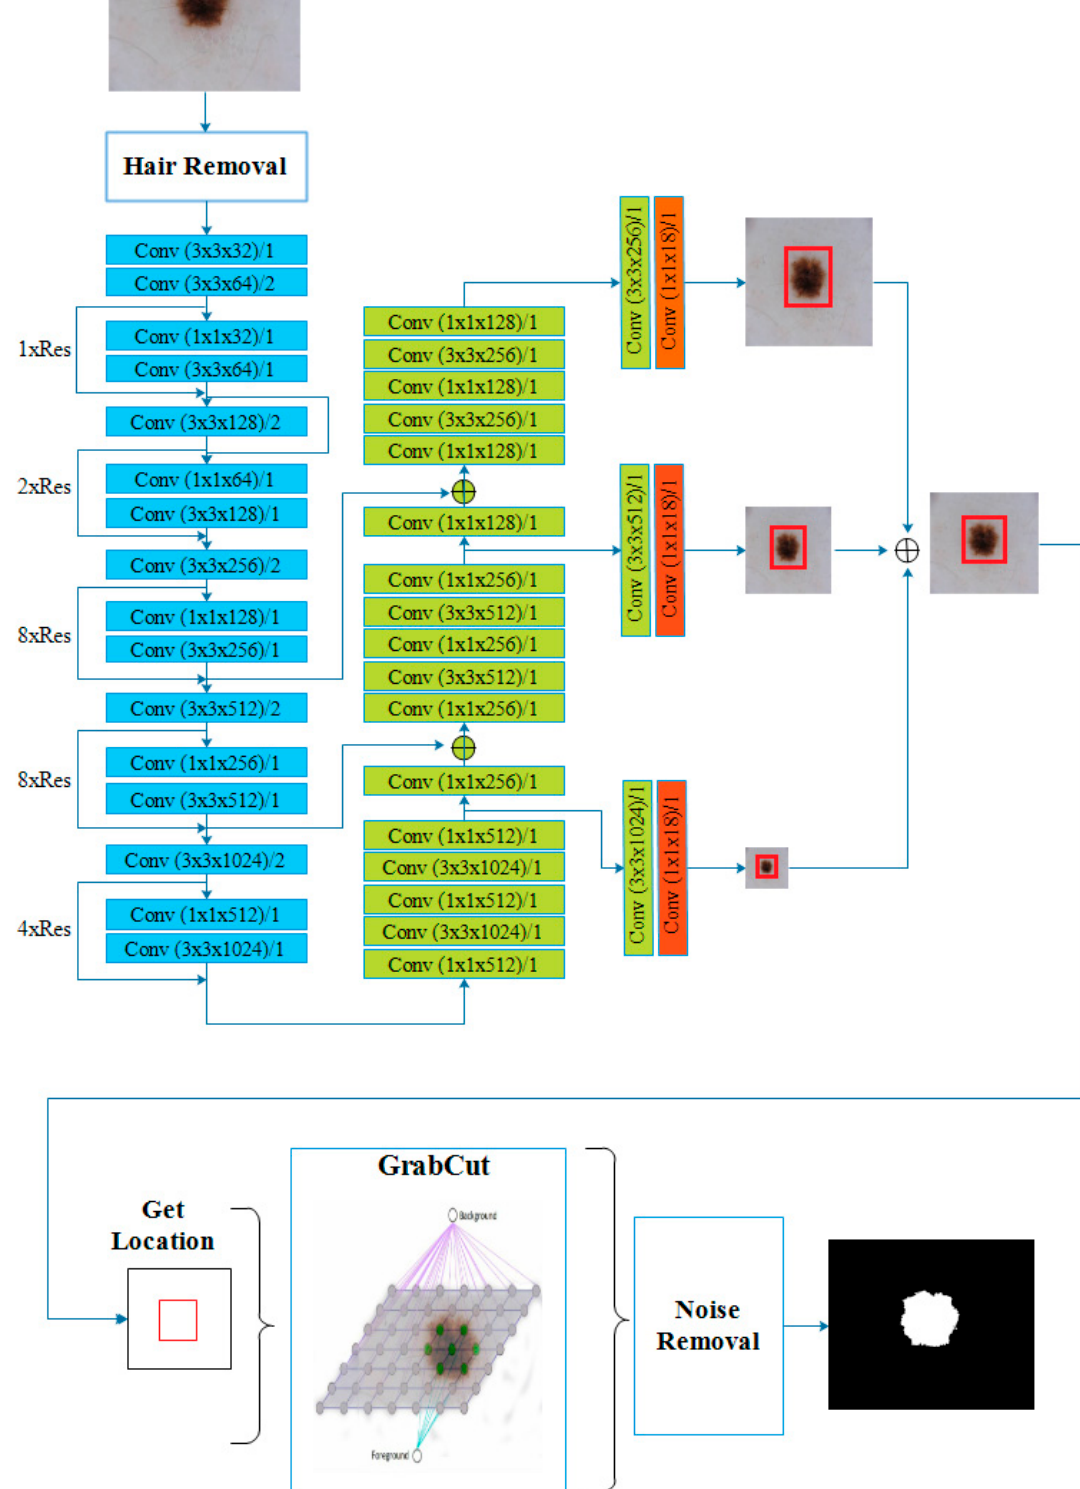
Figure 11. An illustration of the suggested skin lesion segmentation pipeline architecture.